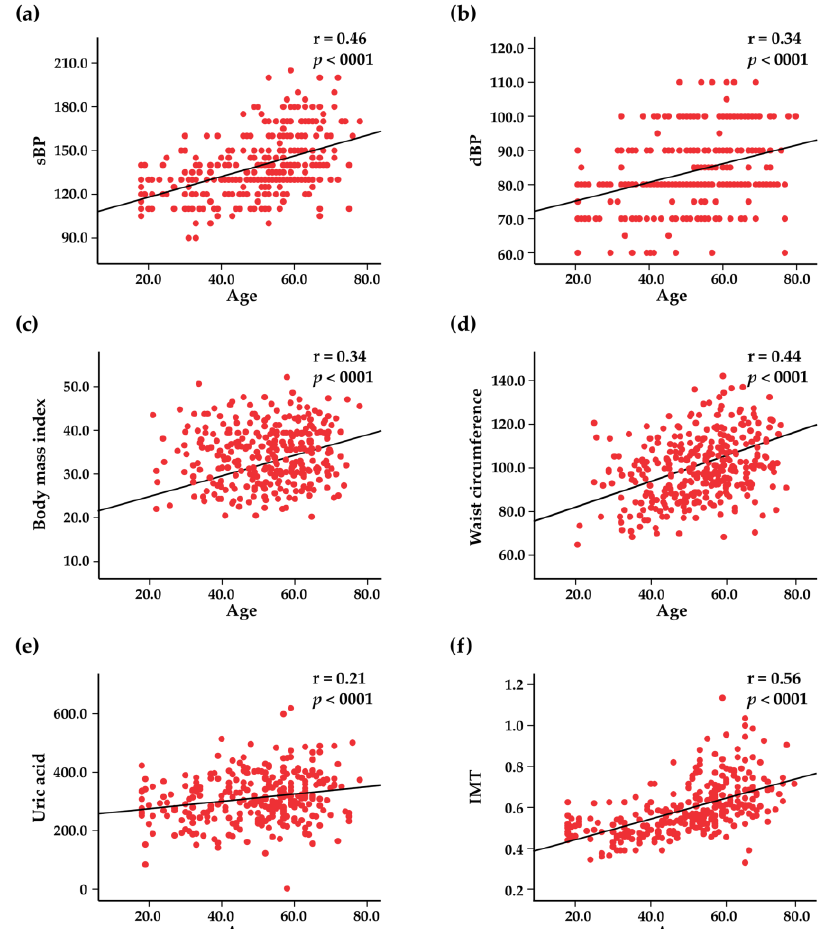
Figure 1. Prevalence of risk factors (%) in the entire study population ( a ) and depending on subject’s sex ( b ).